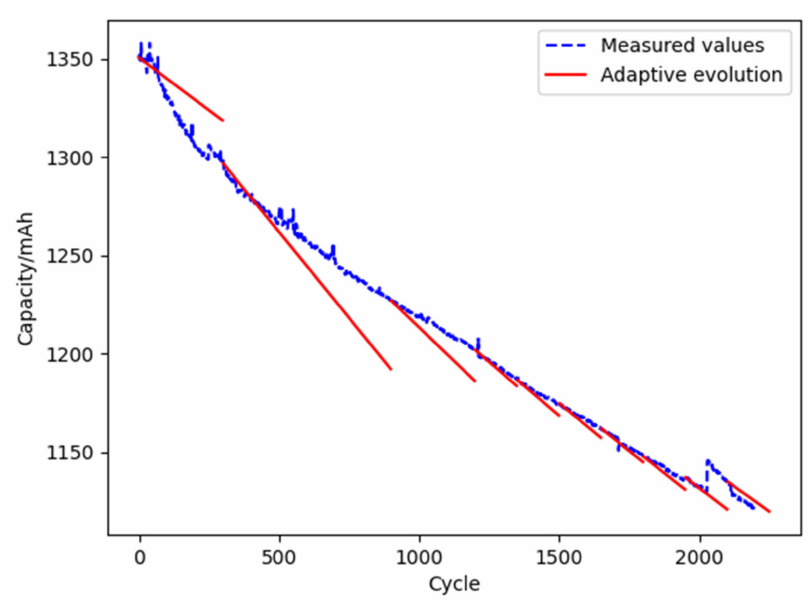
Figure 16. The results of model evolution of L6